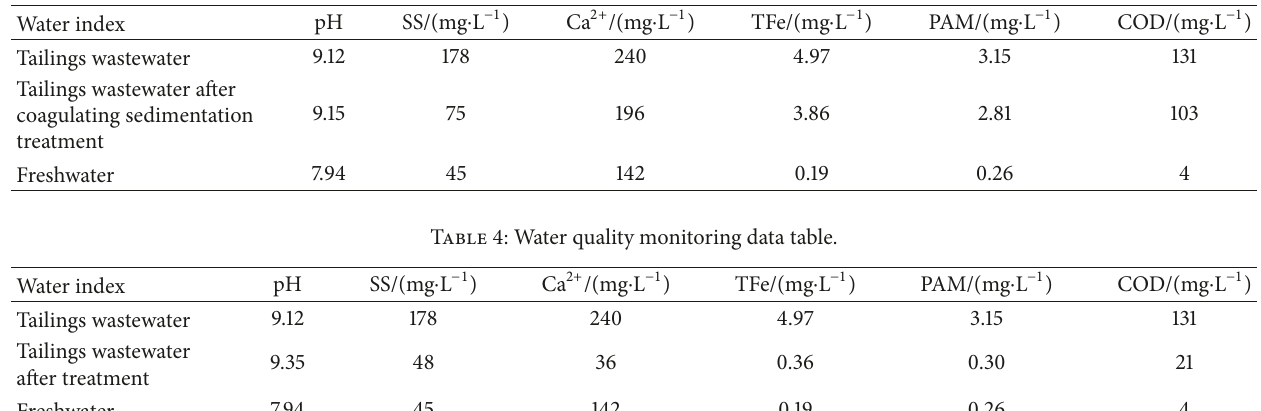
Table 3: Rendering of CYH treating tailings wastewater.